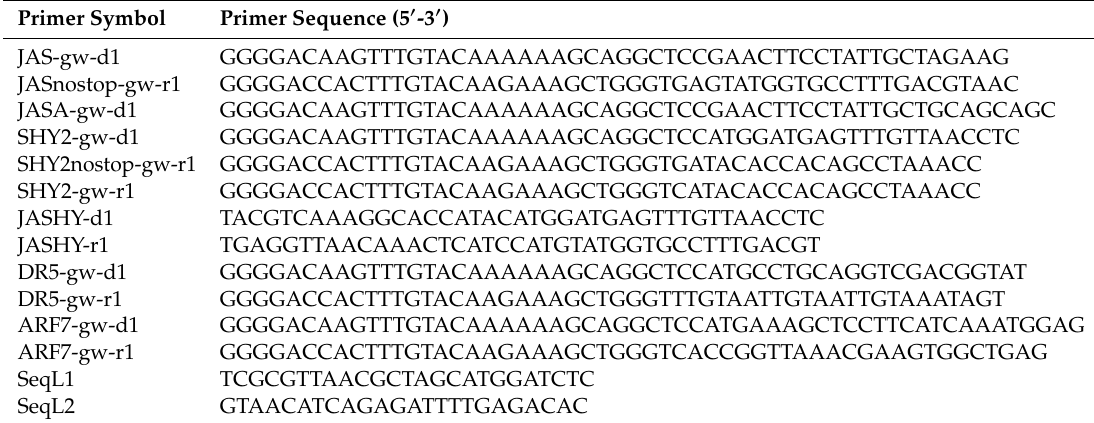
Table 1. Primer sequences used in this